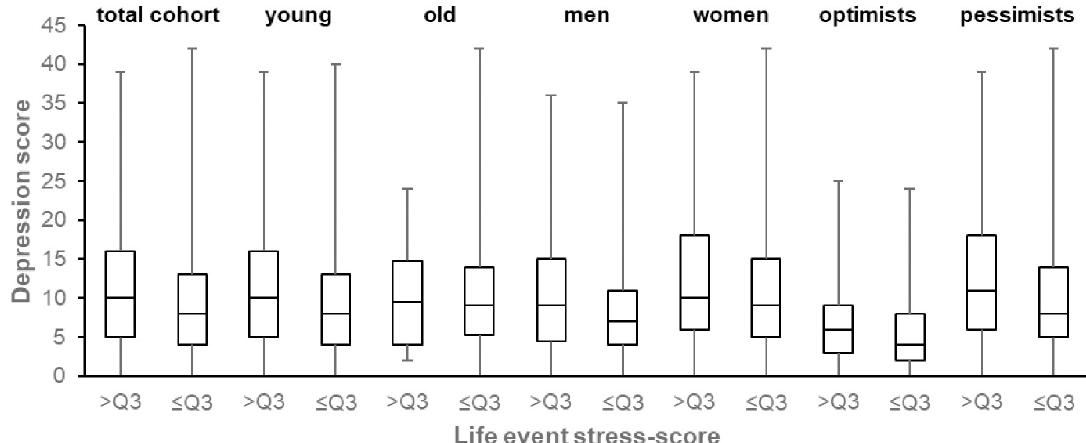
Fig 3. Box and whisker plots demonstrating Center for Epidemiological Studies Depression Scale (CES-D) depression score for Social Readjustment Rating Scale (SRRS) total score > Q3 and � Q3 ( > 63 vs � 63), representing high and low life event stress. Values are shown for the total cohort and stratified by age (young � 65 years vs old > 65 years), sex (men vs women) and optimism (optimists Life Orientation Test-Revised (LOT-R) score > 18 vs pessimists LOT-R score � 18). The horizontal line in each box represents the median with the box representing the interquartile range (Q3-Q1) and the whiskers representing the total range of the data (max-min).